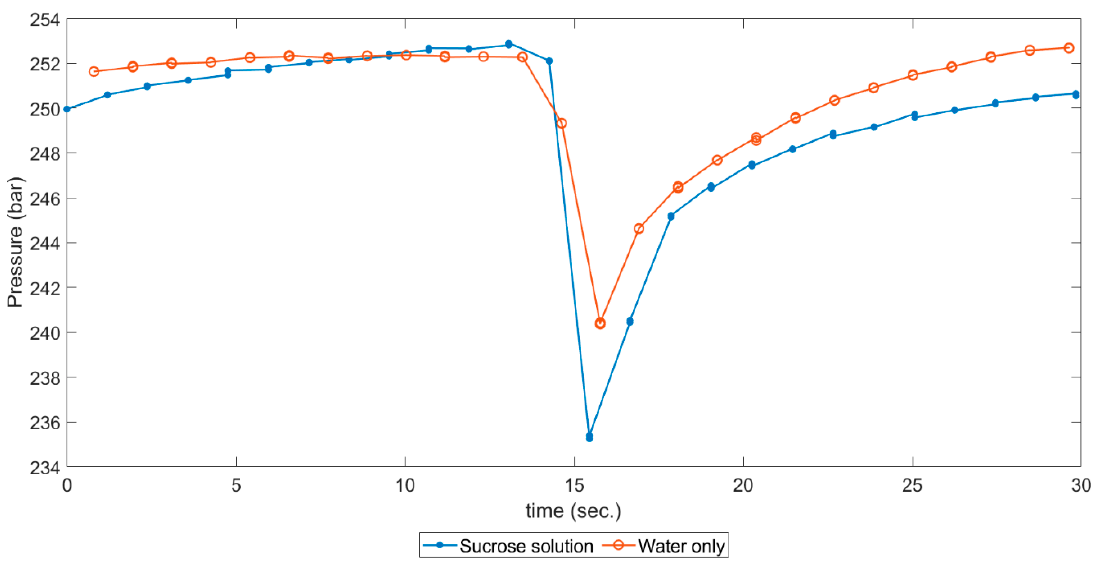
Figure 12. Pressure-drop comparison of simulated clogging for sucrose solution and water-only experiments.